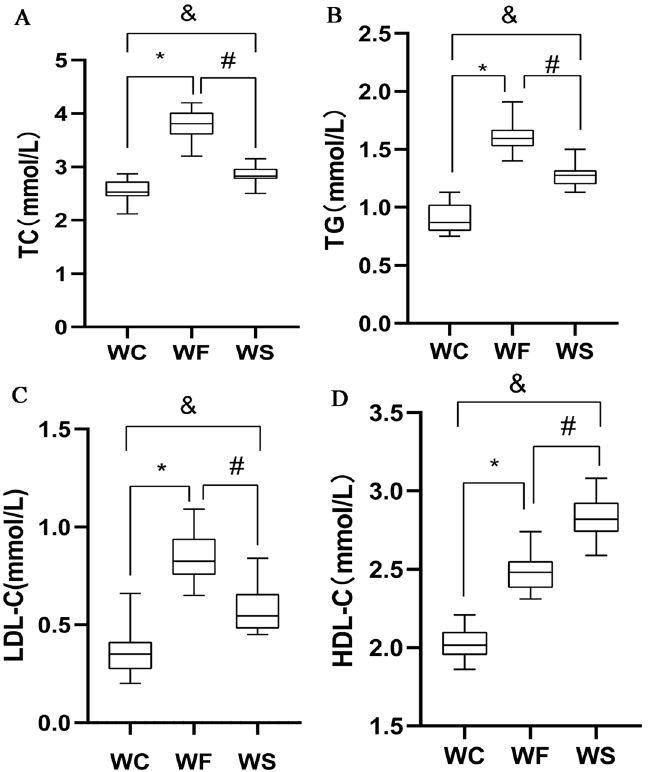
Figure 1. Concentrations of (A) total cholesterol, (B) triglycerides, (C) low-density lipoprotein-cholesterol and (D) high-density lipoprotein-cholesterol in the WC, WF and WS groups. *P < 0.05 WF vs. WC, # P < 0.05 WS vs. WF, & P < 0.05 WS vs. WC.